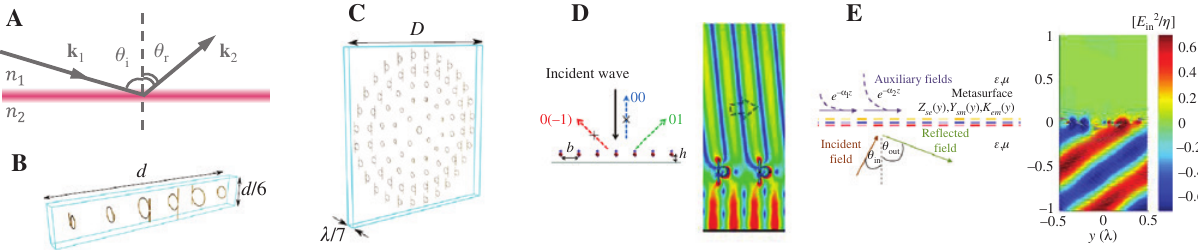
Figure 14: Wavefront manipulations of reflected waves by gradient bianisotropic metasurfaces. (A) Schematic representation of the anomalous reflection scenario, where θ and θ represent the incidence and reflection angles. The meta- i r surface is shown in red. (B) One period of a ground-free metasurface consisting of copper inclusions that provide a linear phase variation of the reflection spanning a 2 π range. Reprinted figure from [63]. Copyright (2015) by the American Physical Society. (C) A nonperiodic meta- surface composed of 6 concentric arrays of omega inclusions and designed for focusing incident waves in reflection. Reprinted figure from [63]. Copyright (2015) by the American Physical Society. (D) Meta-grating for perfect anomalous reflection based on bianisotropic omega inclusions and corresponding electric field distribution of the scattered waves. Reprinted figure from [213]. Copyright (2017) by the American Physical Society. (E) Simulated reflected electric field distribution from a bianisotropic gradient metasurface. Perfect anomalous reflection is accomplished based on the excitation of auxiliary evanescent fields. Reprinted figure from [211]. Copyright (2016) by the American Physical